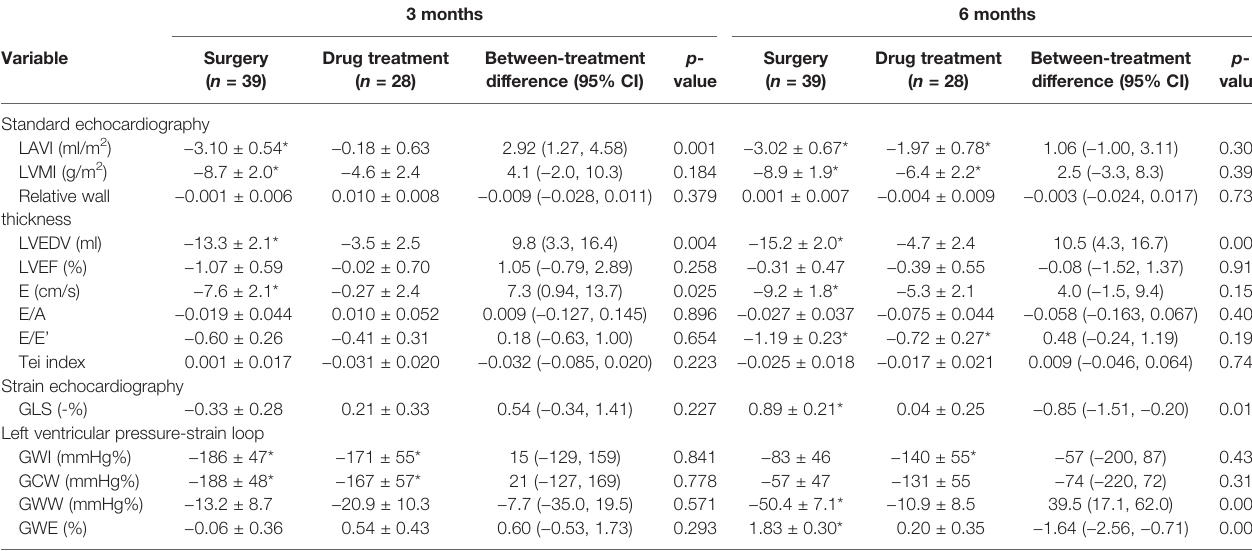
Values per group are least square mean change from baseline ± SEM. The between-treatment difference was calculated by subtracting the changes from baseline in the surgery group fromthoseinthedrugtreatment group.Negativevaluesofthebetween-groupdifferenceindicategreaterreductioninthedrug treatmentgroupthansurgerygroup.A,thepeakatrial fi lling velocity of transmitral fl ow; CI, con fi dence interval; E ’ , the average peak early fi lling velocity of septal and lateral mitral annulus; GCW, global constructive work; GLS, global longitudinal strain; GWE, global work ef fi ciency; GWI, global myocardial work index; GWW, global wasted work; LAVI, left atrial volume index; LVEDV, left ventricular end-diastole volume; LVEF, left ventricular ejection fraction; LVMI, left ventricular mass index. *p < 0.05 vs.